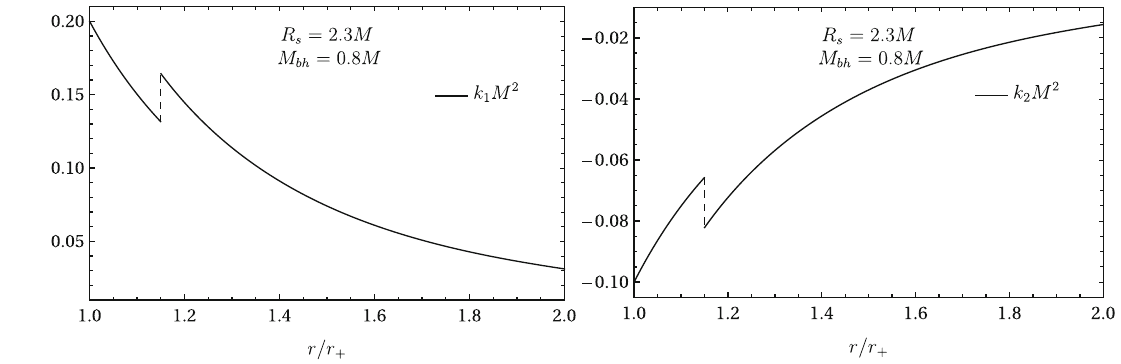
Fig. 7 Tidaltensorcomponents k 1 (left)and k 2 (right)inaSchwarzschildBHsurroundedbyathinsphericalshellfor R s = 2 . 3 M and M BH = 0 . 8